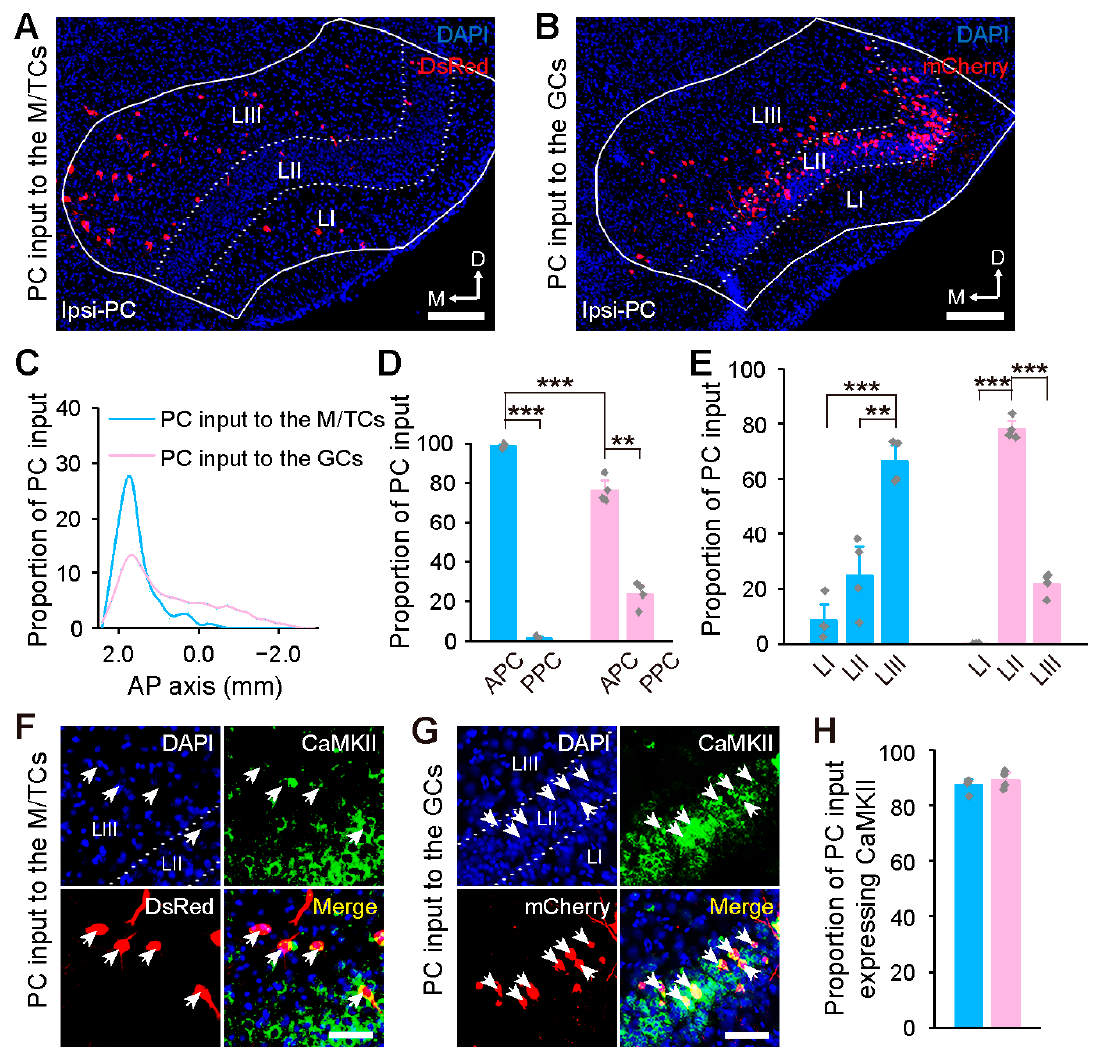
Figure 4. Organization of the centrifugal input from the PC to the OB. ( A , B ) Input neurons in the ipsilateral PC following retrograde tracing from the M/TCs ( A ) and GCs ( B ). ( C ) Cumulative distribution of the input neurons in the PC along the AP axis. ( D ) Subarea distribution of the input neurons in the PC. ( E ) Laminar distribution of the input neurons in the PC. ( F , G ) Identification of CaMKII-expressing input neurons in the PC (indicated by arrowheads) following retrograde tracing from the M/TCs ( F ) and GCs ( G ). ( H ) Proportion of CaMKII-expressing input neurons in the PC. Data are shown as the mean ± s.e.m.; gray rhombuses denote individual animals in ( D , E , H ). Scale bars, 200 µm in ( A , B ); 50 µm in ( F , G ). Two-tailed t -tests were used for ( D ); one-way ANOVA with